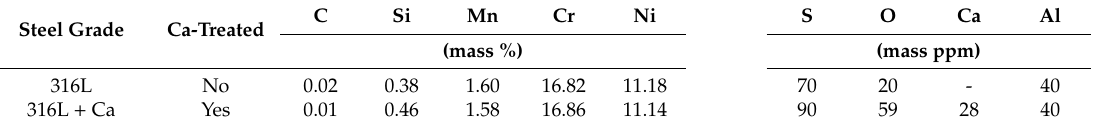
Table 1. Composition of samples of the reference steel (316L) and the Ca-treated steel (316L + Ca). Steel Grade